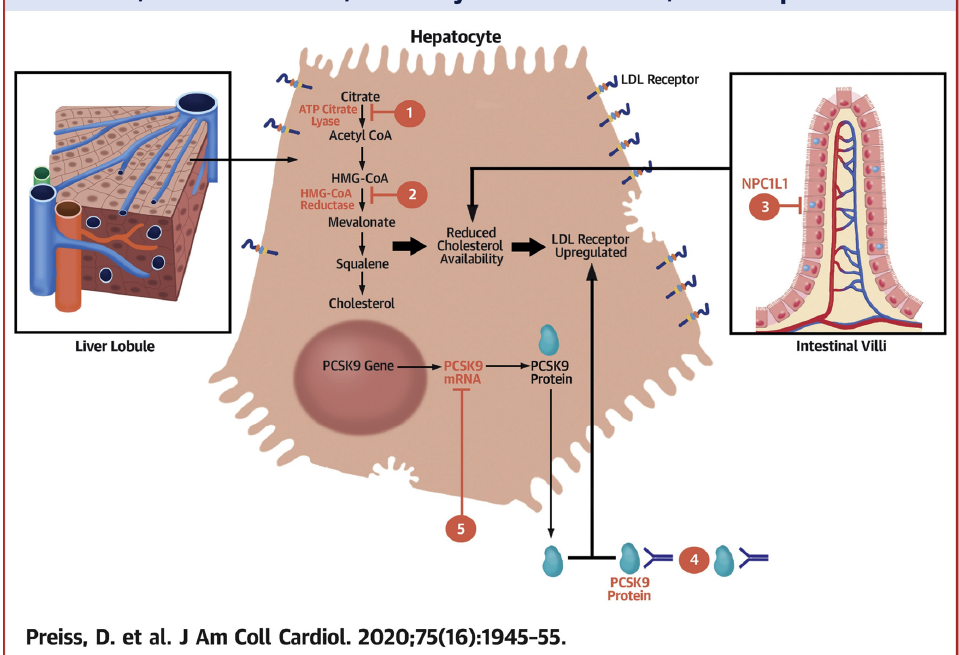
Figure 1. Mechanisms of action of statins, PCSK9 inhibitors, PCSK9 biosynthesis inhibitors, and bempedoic acid (Preiss, D. et al., 2020)